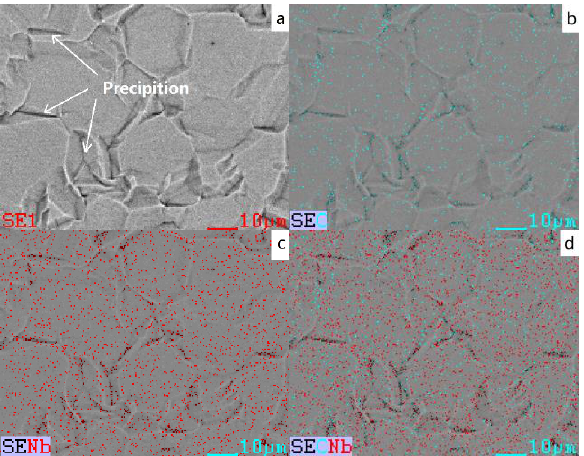
Figure 5. Scanning electron microscopy (SEM) image ( a ) and EDS element mapping ( b ,c, d ) of Fe-28Mn – 10Al – C – 0.5Nb: ( b )C, ( c ) Nb, and ( d ) C and Nb.